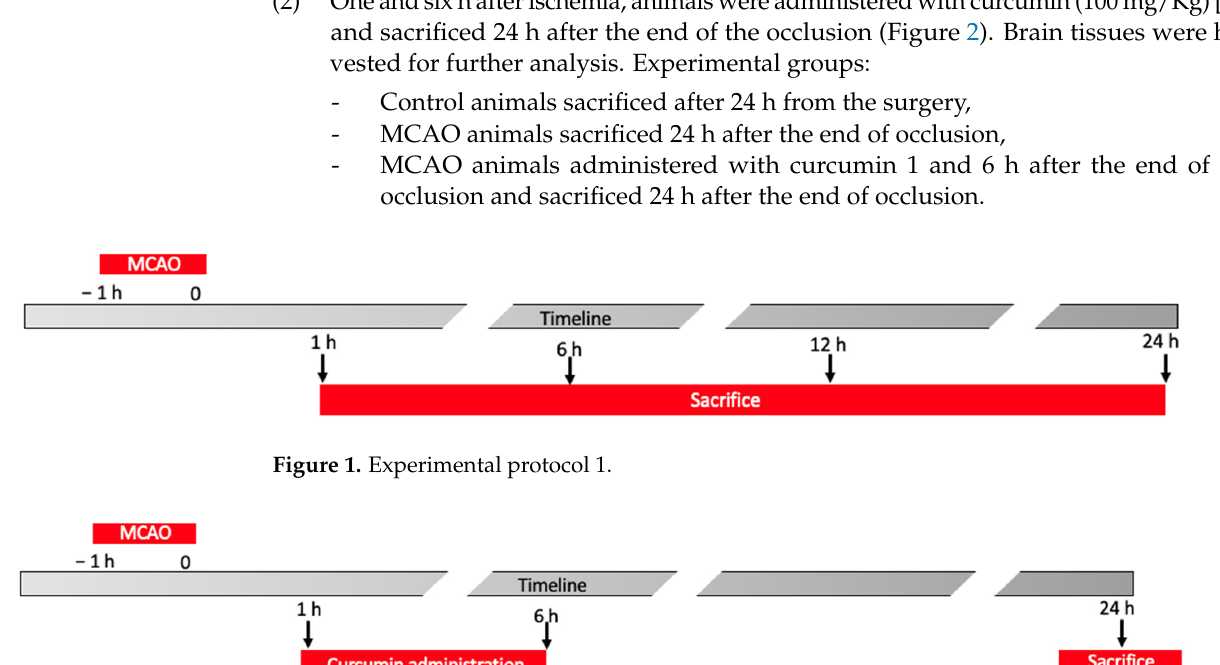
Figure 2. Experimental protocol 2.